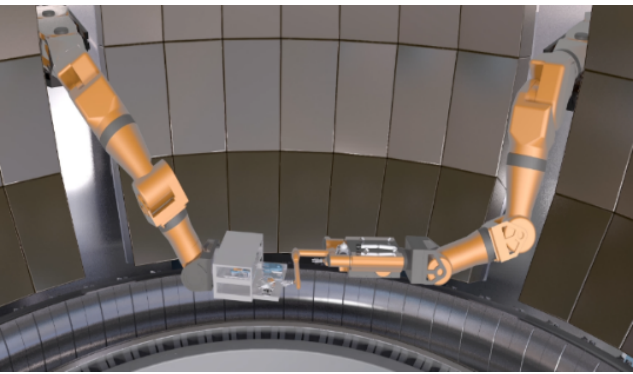
Figure 1. In the fusion environment, many tasks need to be carried out via robotic grasping. In this figure, the robotic arm on the right side is gripping some components from the toolbox on the